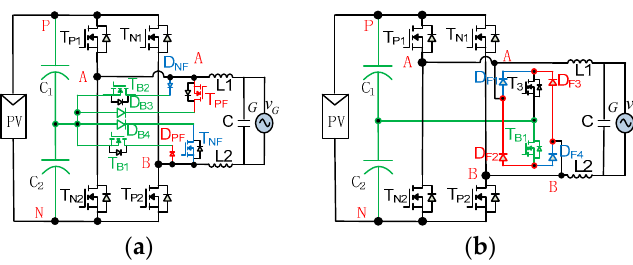
Figure 16. Direct Connection NPC topologies from M = 2, N = 2. ( a ) R1S2 (new); ( b ) R3S2 (new).